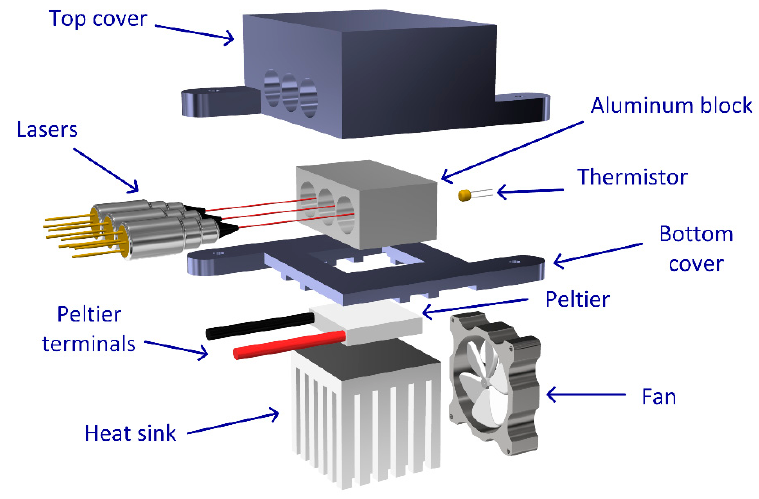
Figure 5. Exploded view of the components for the thermal control section.